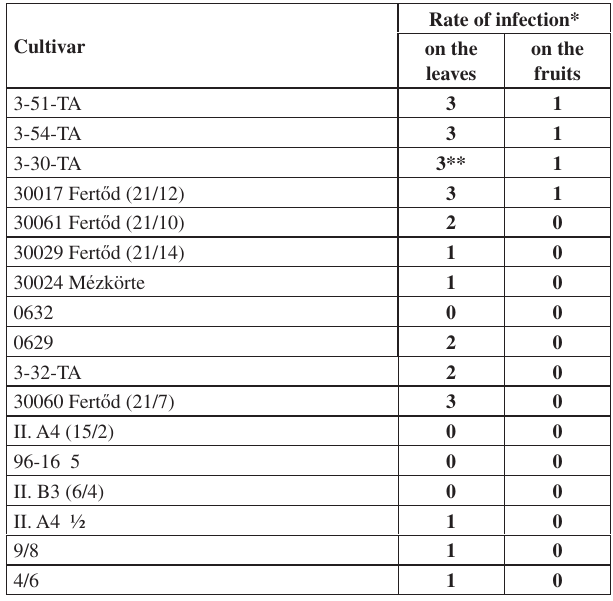
* Rate of infection (scale): 0 = free of infection, 1 = slight infection, 2 = medium infection, 3 = strong infection **Extremely high infestation was detected (infection was much higher than 70, sometimes as high as 100 per cent). Table 2. Relative sensitivity of leaves and fruits of European pear genotypes (commercial cultivars, conventional land varieties, registered local clones, seedlings, wild seedlings) to fi eld infection by Venturia pirina (’Újfehértó’ pear gene bank, Hungary) Rate of infection Total according to the Per cent Trend of infection per relative susceptibility ratio of on leaves as cent of (categories 0, 1,2 and 3)* cultivars compared to fruits cultivars involved involvedon the on the leaves fruits Free of infection 0 0 18.0 % 18.0 % 1 Similar rate of infection on leaves and fruits